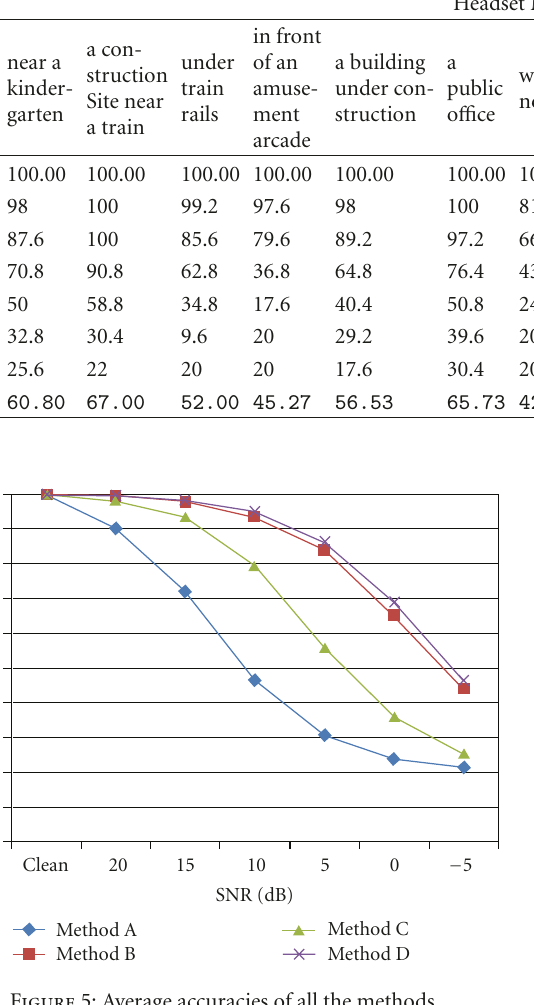
Figure 5: Average accuracies of all the